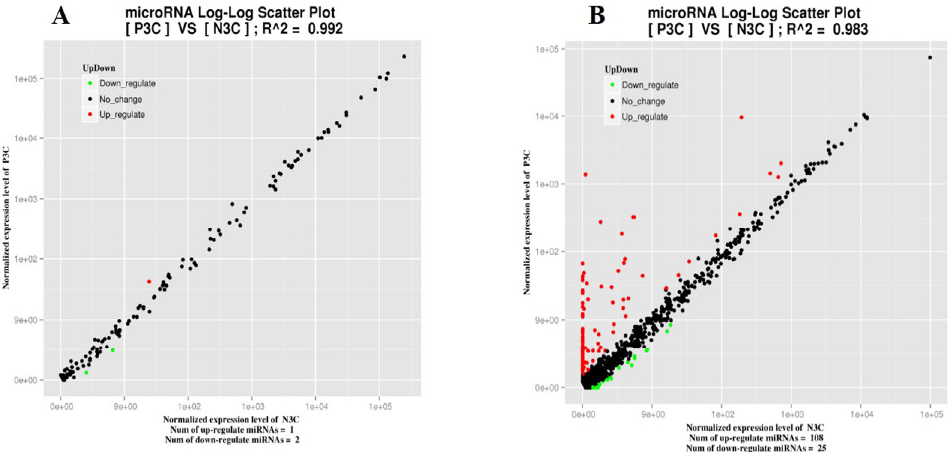
Figure 3. Comparison of expression levels of known miRNAs ( A ) and novel miRNAs ( B ) in PPR vaccine virus-inoculated at 3 dpi (P3C) and mock-inoculated (N3C) sheep ST cells. X and y axes represent the expression levels of the miRNAs of the two groups. The red points represent miRNAs with fold changes greater than 2; the blue points represent miRNAs with fold changes between 0.5 and 2; the green points represent miRNAs with fold changes less than 0.5.